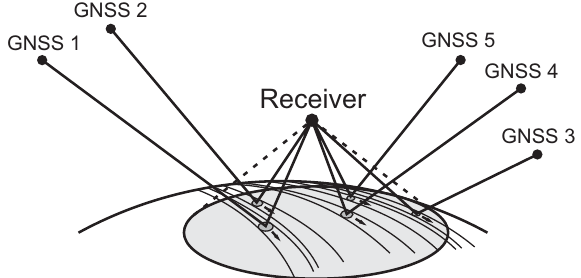
Fig. 1. Illustration of bistatic GNSS reflection geometry. GNSS sig- nals transmitted by GNSS satellites are reflected from the Earth’s surface and received by a dedicated GNSS-R receiver on board a LEO satellite. There are multiple reflection footprints forming sev- eral reflection point ground tracks within the field of view of the satellite (from Mart´ın-Neira et al.